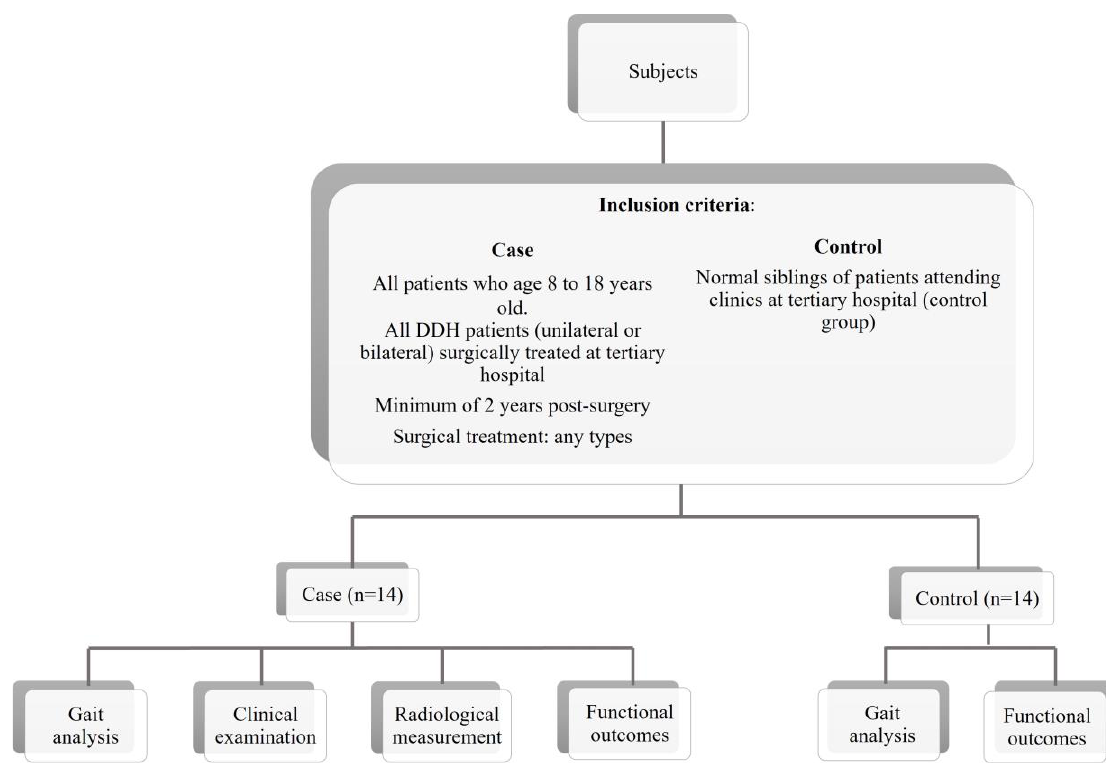
Figure 1. Patients’ recruitment pathway and methodology.